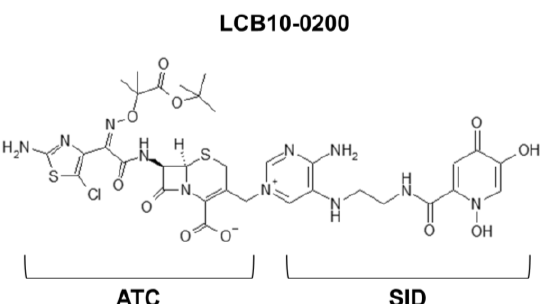
Figure 1. Structure of LCB10-0200. SID: siderophore, ATC: non-siderophore-conjugated cephalosporin.